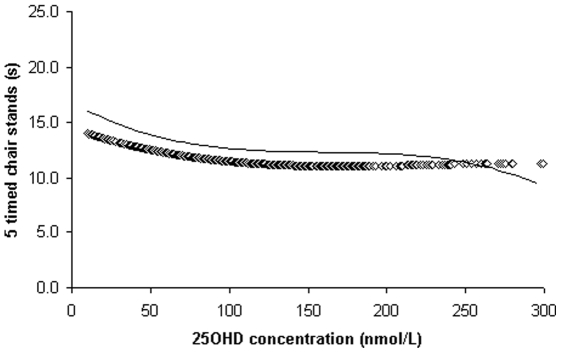
Loess regression plots of 5 timed chair stands measure (seconds) by 25-hydroxyvitamin D (25OHD) concentrations; straight line–for women and diamond line ◊◊ for men.